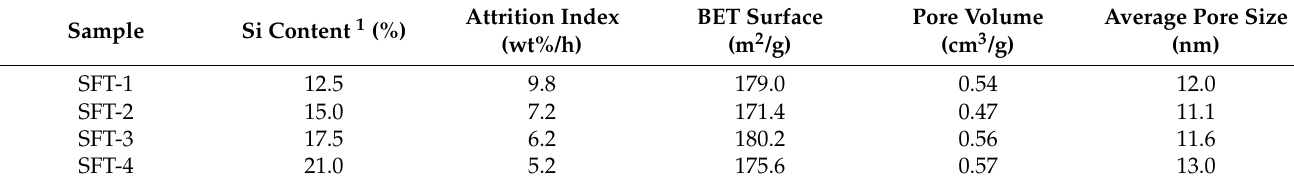
Table 1. Attrition index and physical properties of the prepared catalysts.